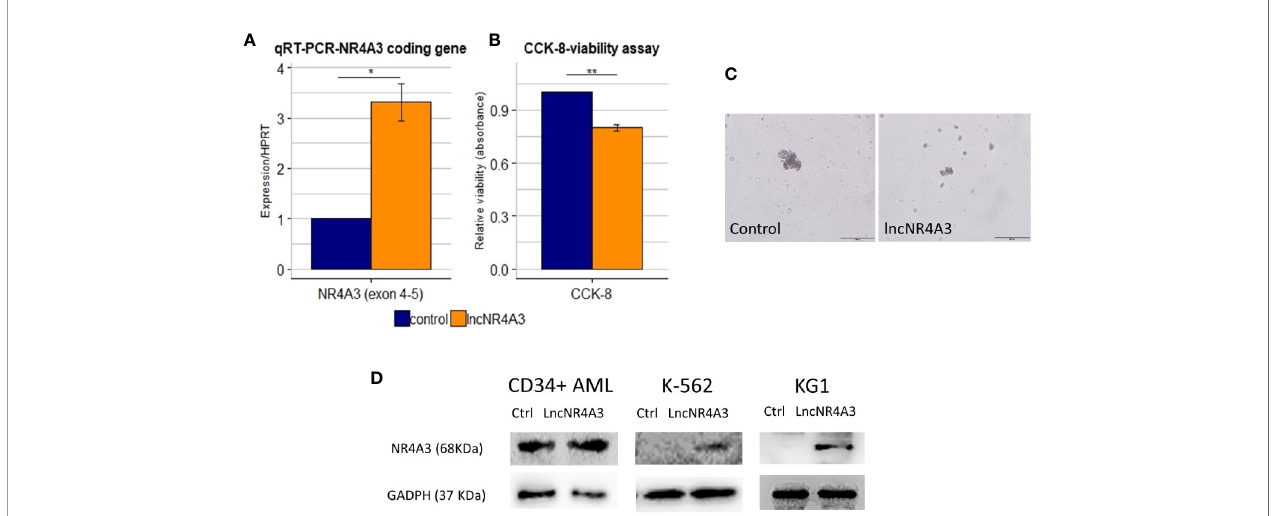
FIGURE 3 | (A) Relative quanti fi cation by quantitative RT-PCR (qRT-PCR) of NR4A3 expression in LncNR4A3 over-expressing K-562 and empty vector control cells shows signi fi cant modulation of NR4A3 at mRNA level in K-562 (mean ± SEM, n=3), similar results for KG1 cells are shown in Supplementary Figure 8 . (B) CCK-8 viability assay results showing reduced viability after lncNR4A3 over-expression in k-562, results for KG1 are shown in Supplementary Figure 8 . (C) Photographs of human hematopoietic CFUs in semi-solid culture (bar: 200µm), see additional colonies in supplementary information. Left: representative colony from control CD34+ cells after 15 day in culture. Right: representative cluster from LncNR4A3 over-expressing cells 15 days in culture. (D) Immunoblots showing the reactivation of NR4A3 protein in AML CD34+ cells, KG1 and K-562 cells. * : <0.05, *** :